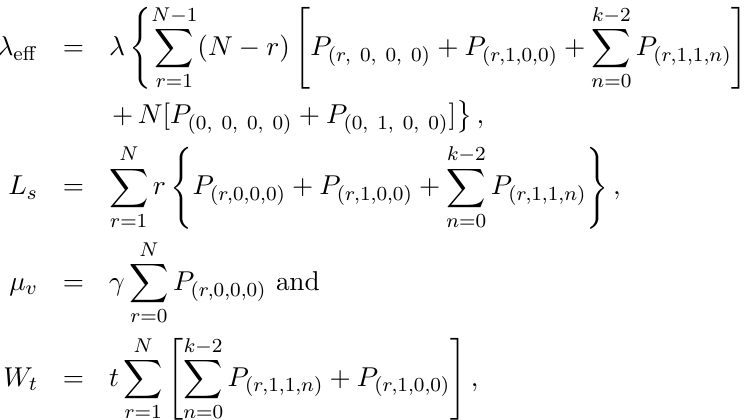
l queueing system with a hybrid scheme. , t , t have the same meaning as in a s v